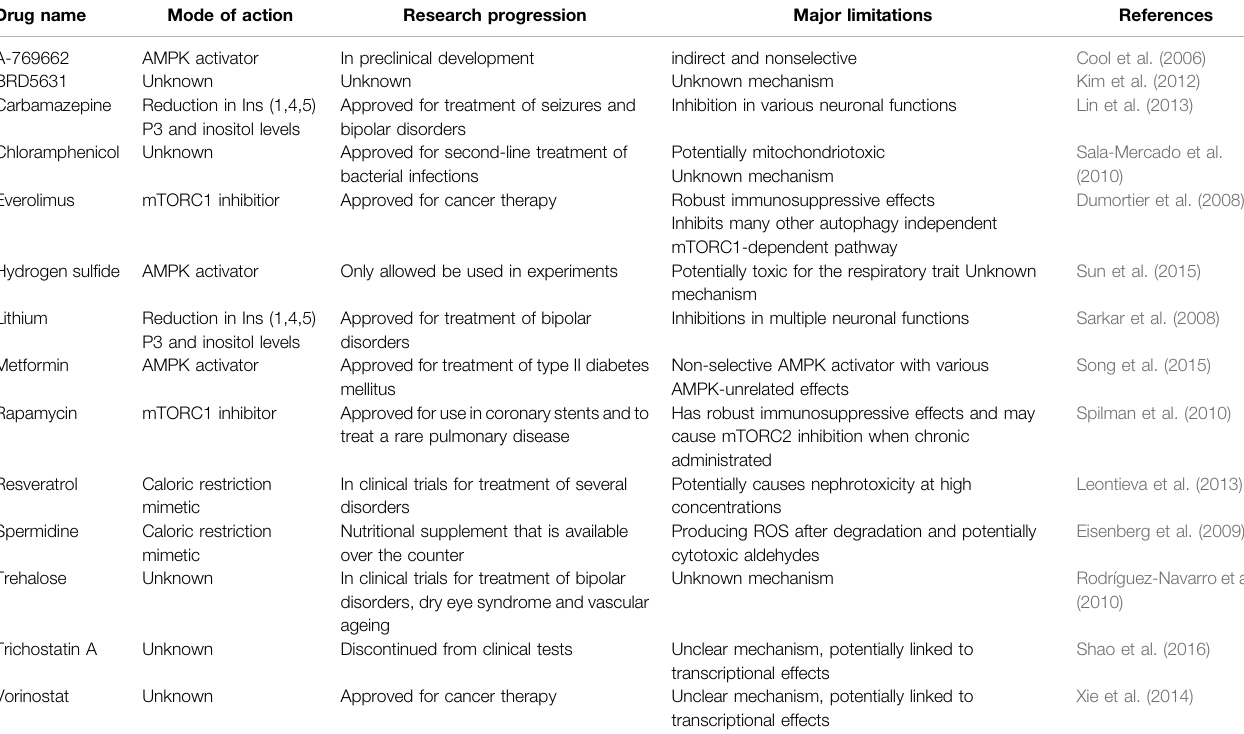
TABLE 1 | Main activators of autophagy available to date and their limitations. AMPK, AMP-activated protein kinase, mTORC1, mechanistic target of rapamycin complex